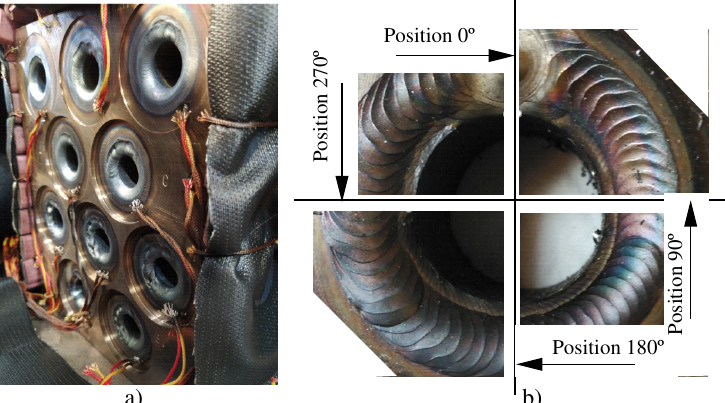
Figure 9. Tubesheet of mockup 2 after finishing the welds. ( a ) General view; ( b ) Positions of coupon cut in a joint to obtain the